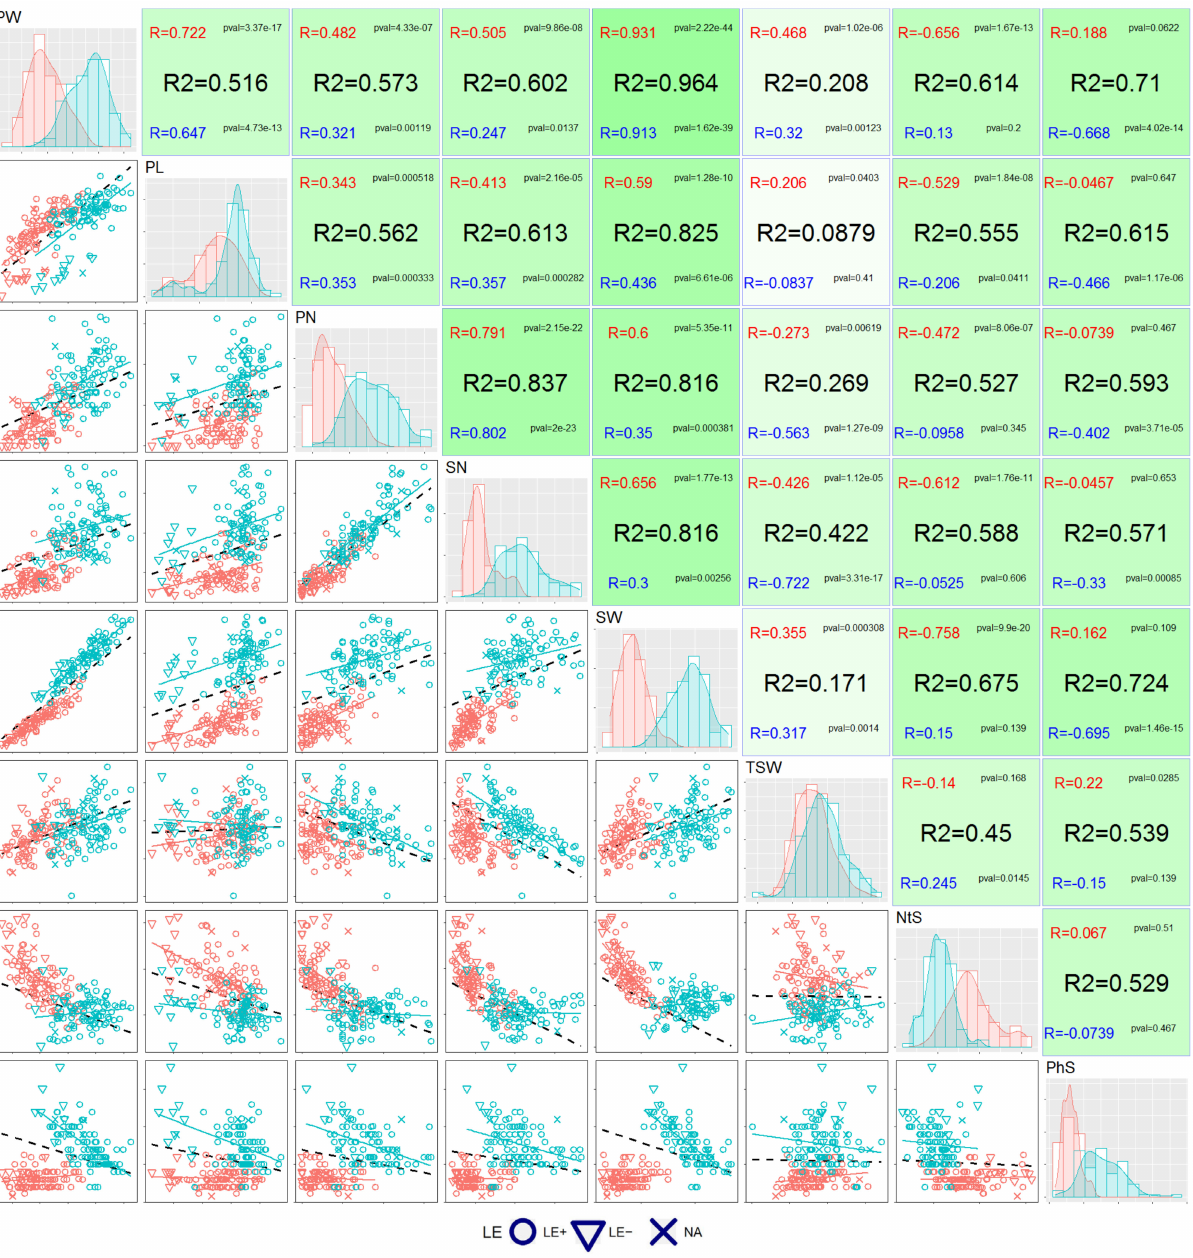
Figure 2. Correlation matrix plot showing the results of pairwise correlation analysis of pea cultivar traits. The lower triangular matrix is composed of scatter plots in which the blue markers represent single inoculation with rhizobia (Rh), while the red markers represent double inoculation with rhizobia and mycorrhizal fungi (Rh + AM); the solid lines are corresponding linear regression graphs; and the dotted line is the mean regression graph of the joined (Rh and Rh + AM) linear regression model. The upper triangular matrix shows the Pearson correlation coefficients with p -values for the Rh (red) and Rh + AM (blue) samples as well as the coefficients of determination for the joined (Rh and Rh + AM) linear regression model. The matrix diagonal comprises the distribution plots (histogram + density) of the traits of both inoculations, Rh (red) and Rh + AM (blue). The following traits are presented: PW—shoot weight, g; PL—shoot length, cm; PN—pod number; SN—seed number per plant; SW—seed weight per plant, g; TSW—thousand-seed weight, g; NtS—seed nitrogen content, mg/g; PhS—seed phosphorus content,